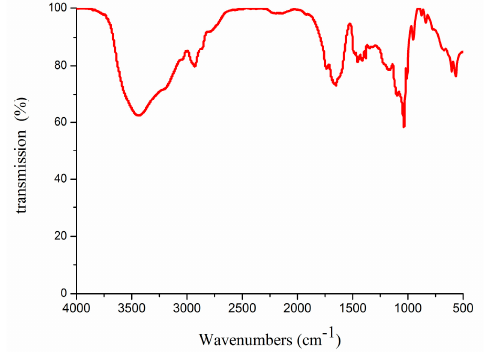
Figure 2. FTIR spectrum of PASD.